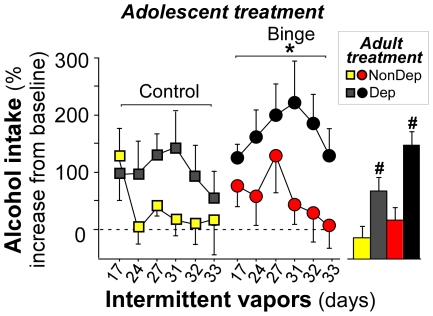
Voluntary binge drinking early in adolescence augments relapse-like drinking in adult non-dependent and dependent male Wistar rats.Chronic intermittent alcohol vapor produced significant elevations in alcohol self-administration by Dependent rats (black) during 30-min operant tests relative to Non-dependent rats. Animals with a history of adolescent binge alcohol drinking (right panel of line graph) also drank more than non-binge controls during adulthood. Data are expressed as mean ± SEM (n = 6–10/group). Dependent and non-dependent groups did not differ in adolescent consumption levels (p = 0.34). *p<0.05 main effect of adolescent alcohol binge drinking. #p<0.05 main effects of adult alcohol dependence.